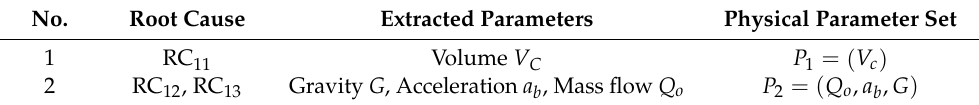
Table 8. Physical parameters extracted from root causes of “Unable to dispense TCM continuously”.